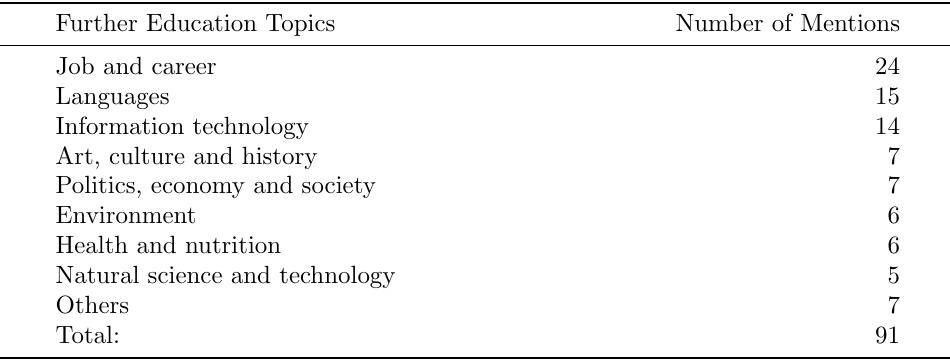
Table 1: Further education topics in the population